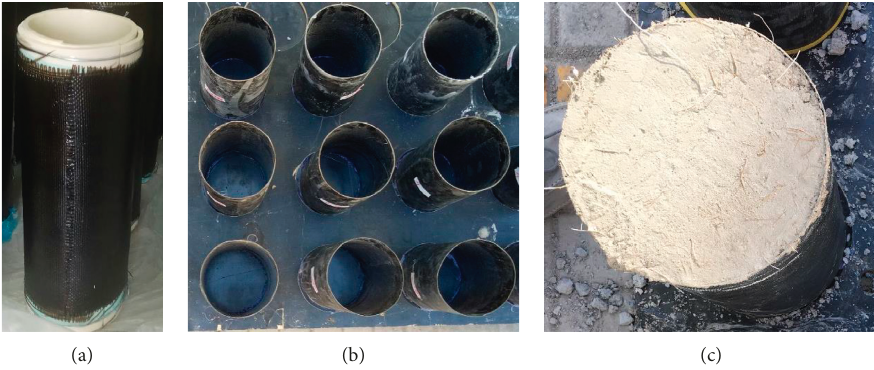
Figure 1: BFRP tubes preparation. BFRP tubes (a, b) without CFRC and (c) with CFRC.